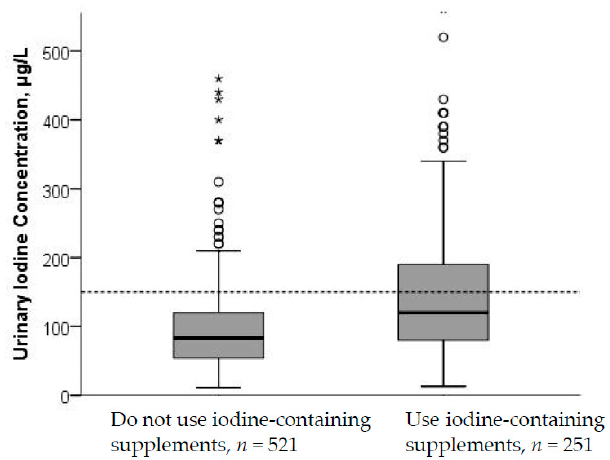
Figure 2. UIC by use of iodine-containing supplements. Five cases with UIC > 500 µg/L were excluded